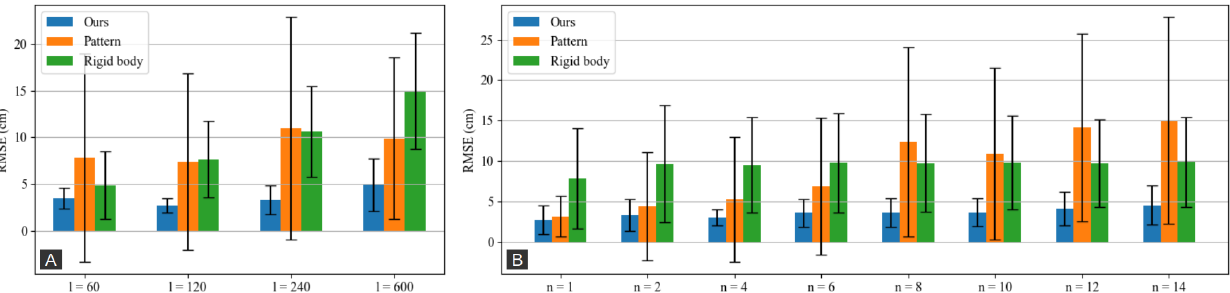
Figure 5. Comparison of gap filling methods performance for each ( A ) gap length ( l ) and ( B ) number of missing markers ( n ). Vertical error bars represent standard